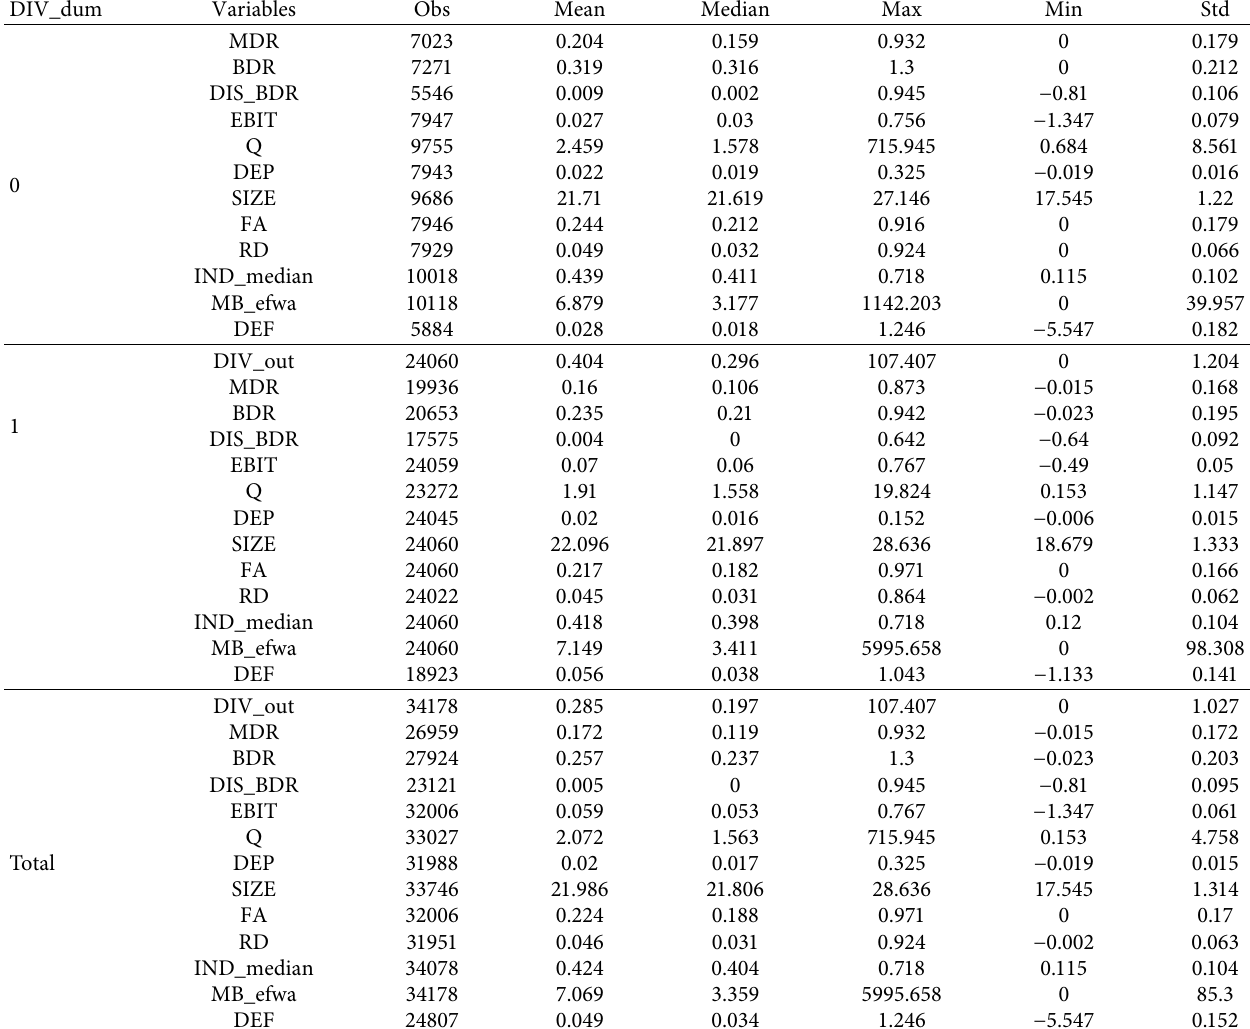
Table 1: Descriptive